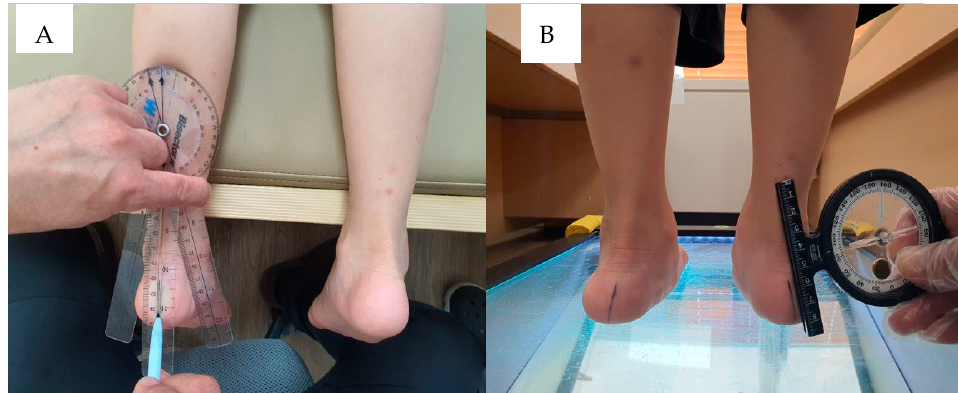
Figure 1. Measurement of the Resting Calcaneal Stance Position Angle (RCSPA) ( A ). Producing the centerline of the calcaneus ( B ). Measurement of RCSPA at a relaxed standing position. The foot posture index (FPI) was used to observe the shape of the foot, with scores